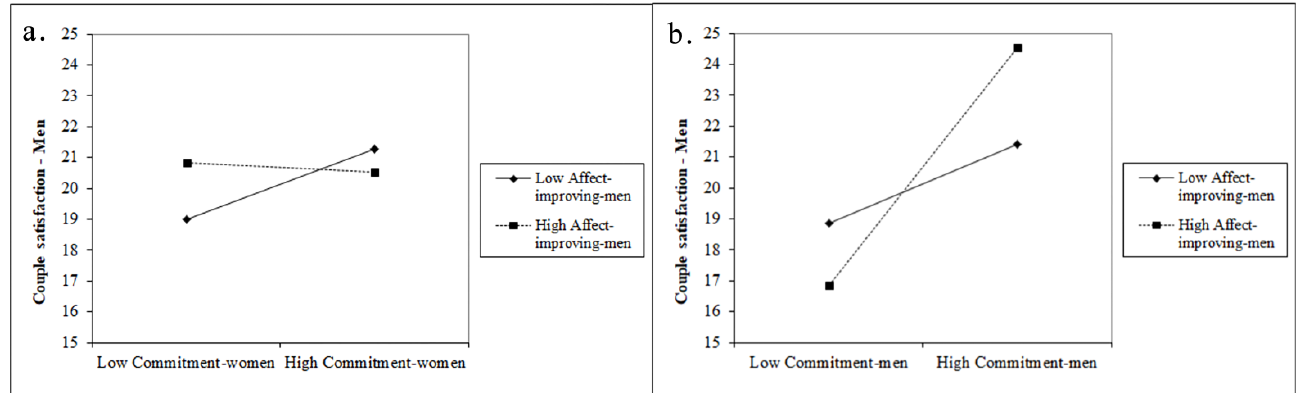
Figure 3. Men’s couple satisfaction with women’s or men’s low and high commitment for men that use less vs. more interpersonal affect-improving strategies: ( a ) men’s satisfaction with women’s commitment and men’s use of interpersonal affect-improving strategies; ( b ) men’s satisfaction with their commitment and use of interpersonal affect-improving strategies.